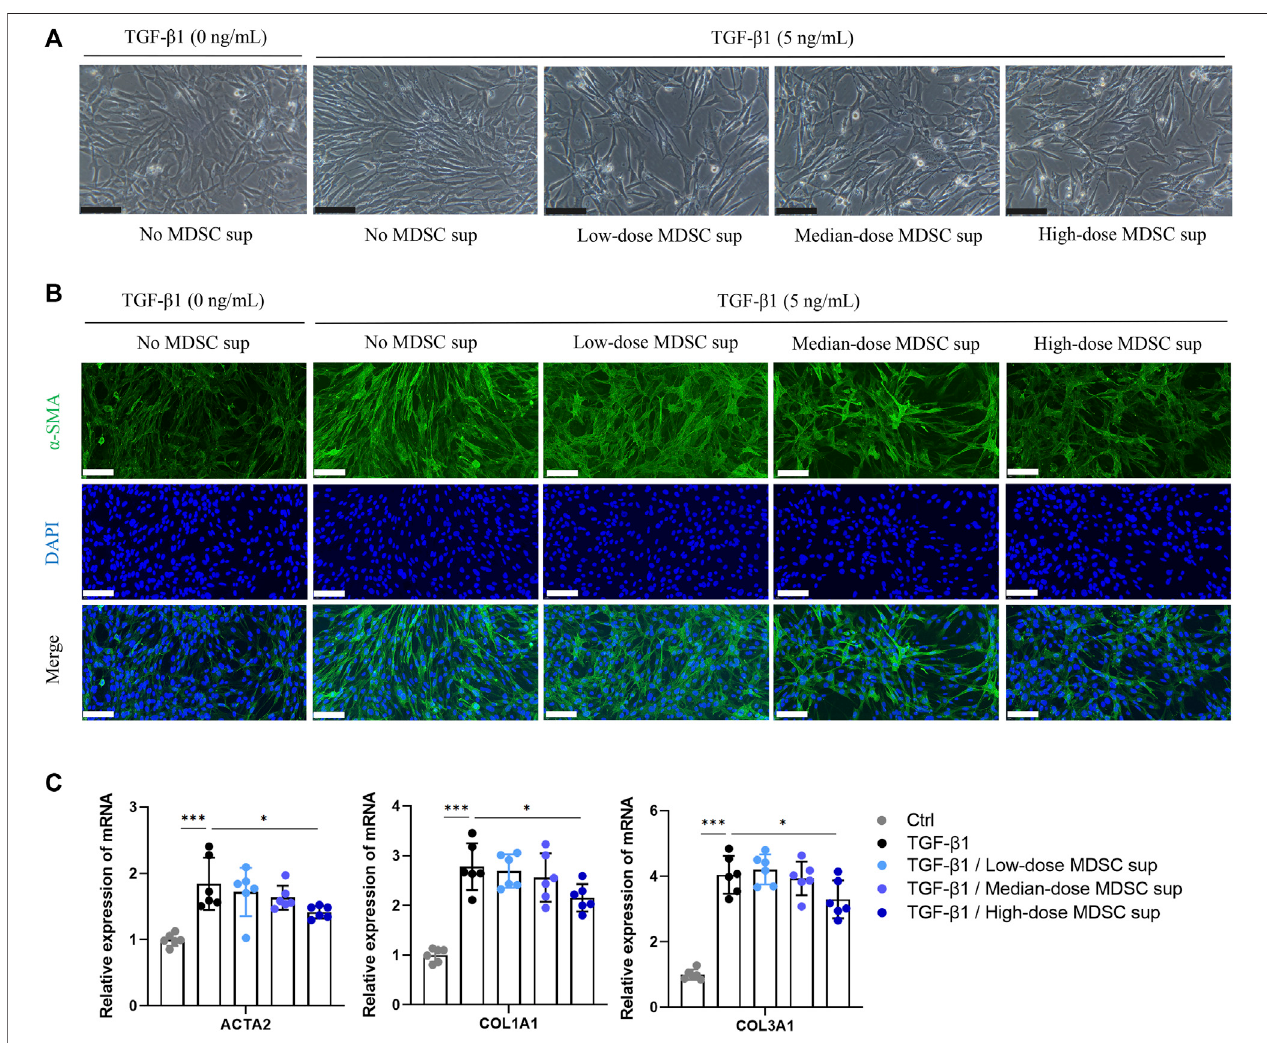
FIGURE 1 | MDSC supernatant inhibits the TGF- β 1-induced myo fi broblastic differentiation of MSCs. (A) BM-derived CD11b + Gr + MDSCs were obtained by fl ow cytometry and cultured in normal medium for 24 h at a density of 5 × 10 4 cells/mL (low dose), 1 × 10 5 cells/mL (medium dose), and 5 × 10 5 cells/mL (high dose). Then, the culture supernatants were collected. MSCs were cultured with different doses of MDSC supernatant containing TGF- β 1 (5 ng/mL) for 24 h, and cell morphology was observed under a microscope. Scale bar: 100 μ m. (B) Immuno fl uorescence staining of α -SMA in MSCs. Scale bar: 100 μ m. (C) mRNA expression of ACTA2, COL1A1 and COL3A1 in MSCs was normalized to GAPDH expression and analyzed by qPCR. Valueswere expressed as mean ± standard deviation (mean ± SD). * p < 0.05; ** p < 0.01; *** p < 0.001.